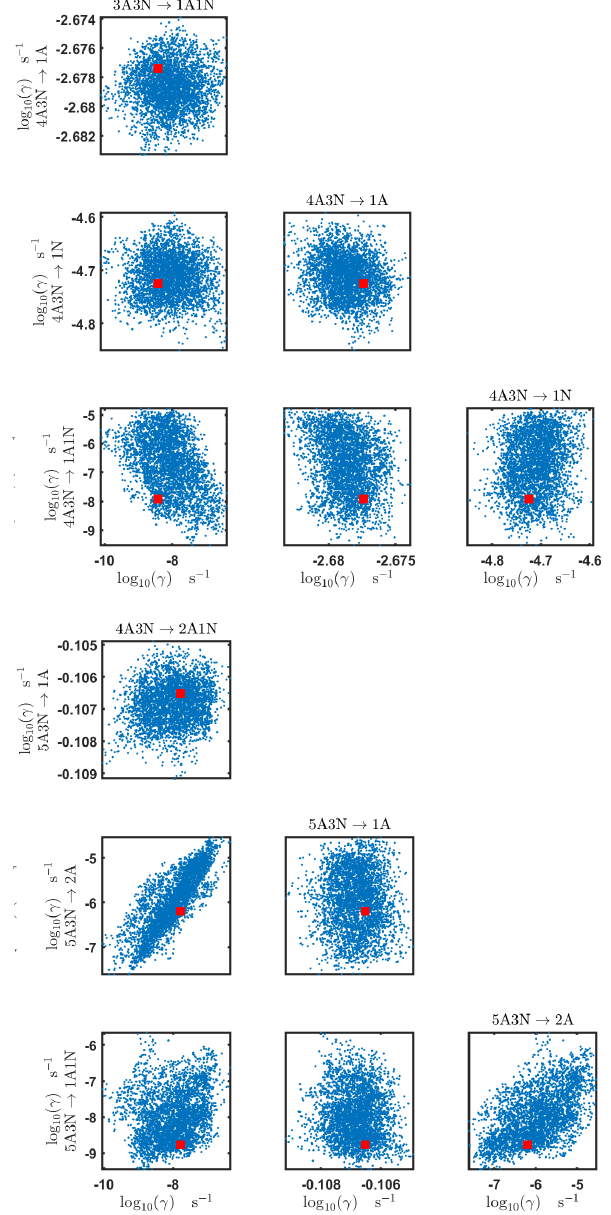
Figure C6. Pairwise marginal posterior distributions (for parame- ter indexes ranging from 17 to 24) of the base 10 logarithm of the evaporation rates (units given in s − 1 ) from time-dependent mea- surements of the cluster concentrations with time resolution com- prising 1.5min at the temperature 278K. Red rectangles denote the baseline values from Olenius et al. (2013b) used to generate the synthetic data. The notation xAyN corresponds to a cluster with x sulfuric acid and y ammonia molecules.